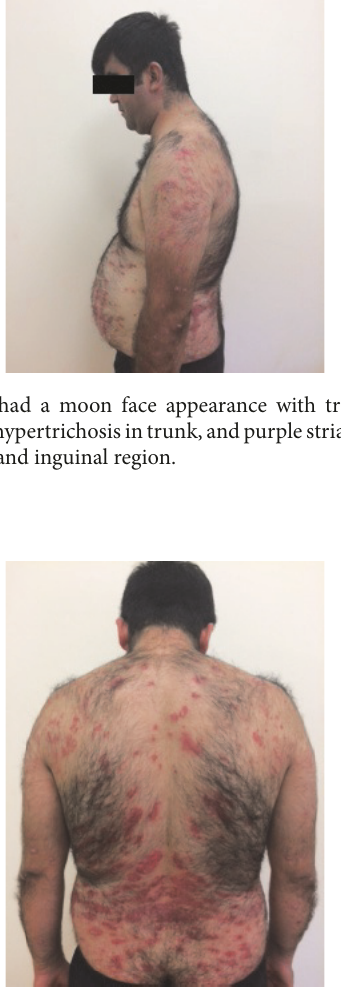
Figure 2: He had numerous erythematous, scaly psoriatic plaques located on the shoulders, all extremities, dorsum of hands, and feet and at the intertriginous